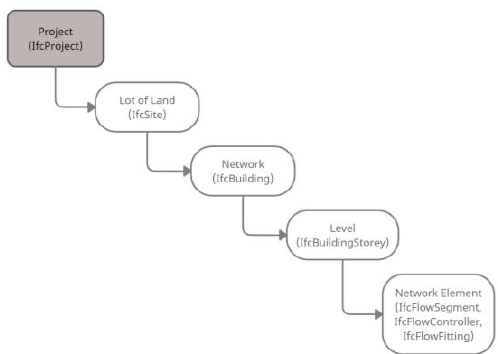
Figure 3. Underground utility networks data